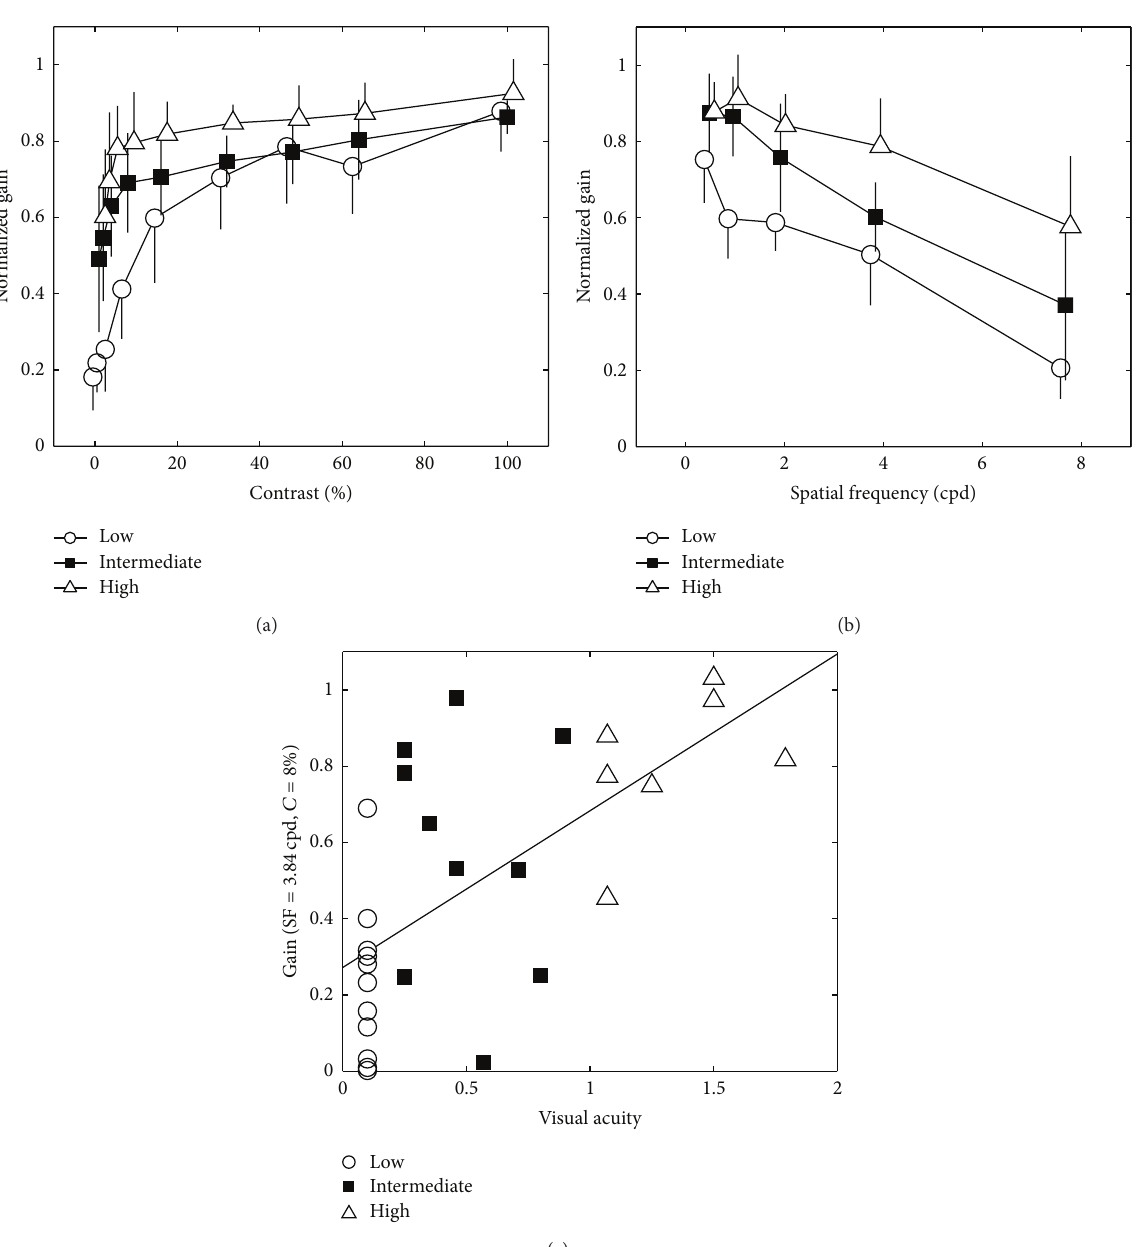
Figure 3: For each of the three groups (low, intermediate, or high visual acuity), the averaged normalized GFR gains are pooled over the 5 levels of spatial frequency and plotted against contrast in (a) and pooled over the 9 levels of contrast and plotted against spatial frequency in (b). The error bars represent standard error of the mean. The normalized GFR gain in response to a moving Gabor patch with a spatial frequency of 3.84 cpd and a contrast of 8% is plotted against the visual acuity score in (c); each symbol represents a single